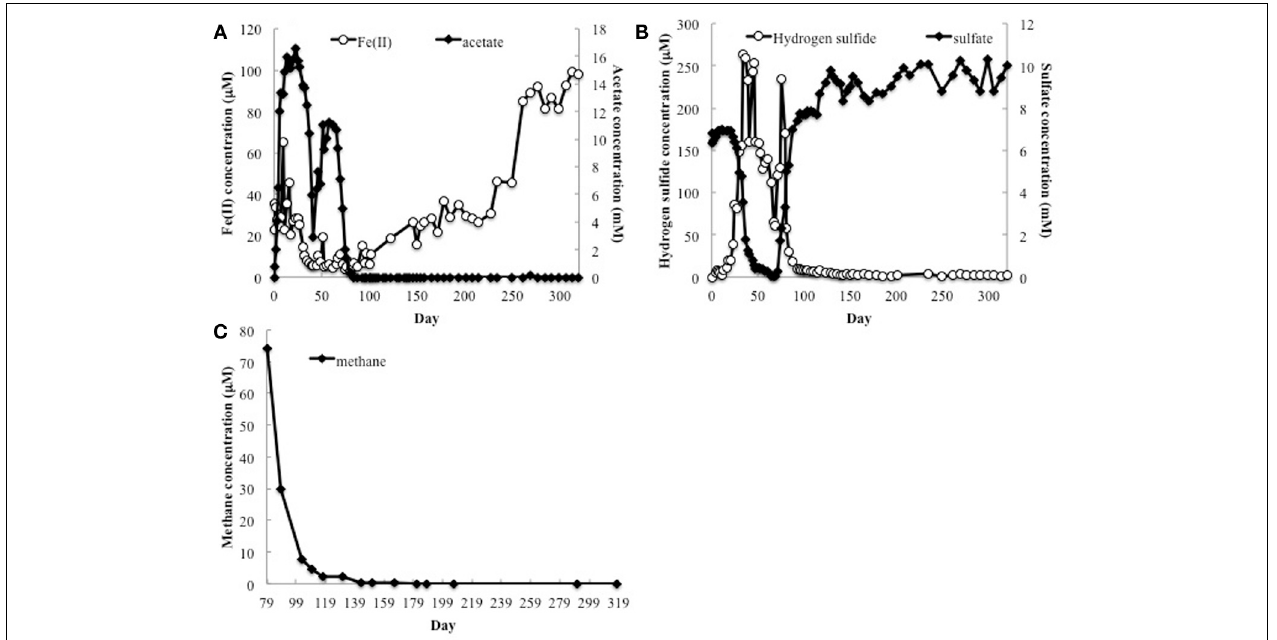
FIGURE 1 | (A) Fe(II), acetate, (B) sulfate and H 2 S concentrations in groundwater collected from well CD-01 over the course of 320 days. (C) Methane concentrations in the subsurface starting 79 days after initial acetate injections (day